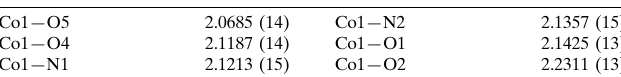
Selected bond lengths (A˚ ).